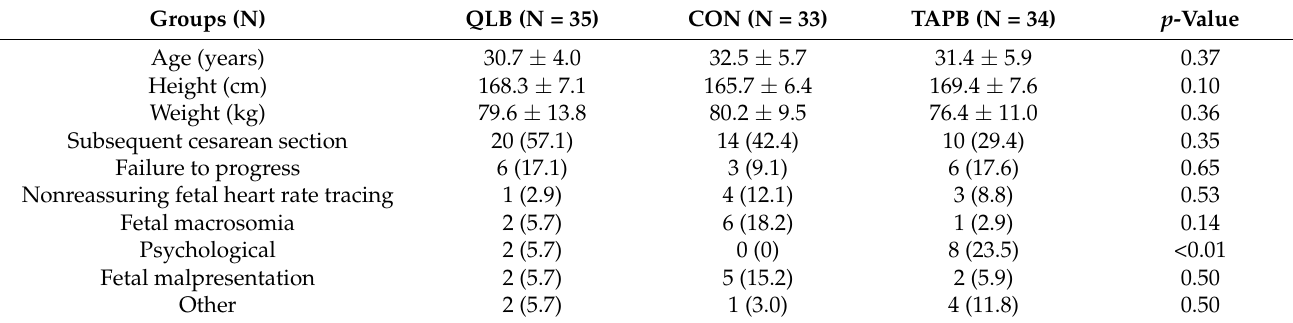
Table 1. Patient demographics and indications for cesarean